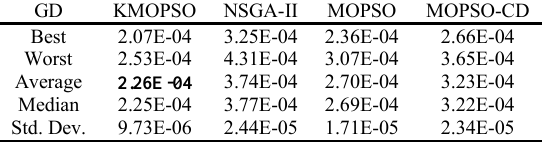
Fig. 6. Box plots for the metrics of generational distance (a), spacing (b), maximum spread(c), KMOPSO (1), NSGA-II (2), MOPSO (3), MOPSO-CD (4). Table 5 . Results of the generational distance metric for FON.